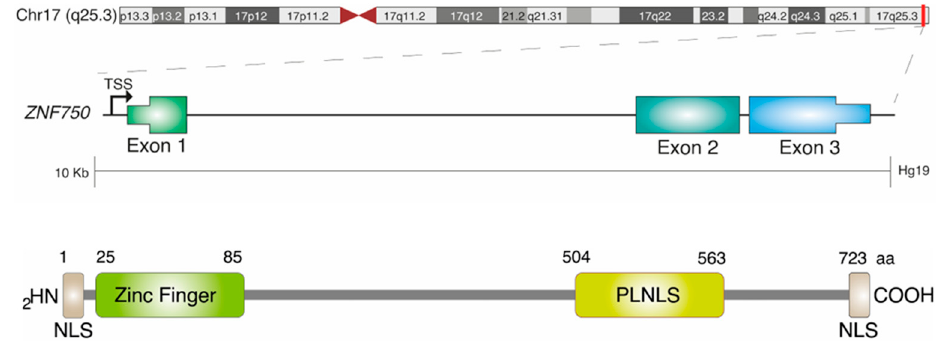
Figure 1. Schematic representation of ZNF750 gene organization and protein structure. ZNF750 gene is located on chromosome 17. The structural organization of ZNF750 consists of an atypical C2H2 zinc finger motif in the amino terminal domain, which is required for the binding of ZNF750 to DNA and regulating gene transcription. In addition, two highly conserved PLNLS sequences that are required for protein–protein interaction are present in the carboxy terminal domain.